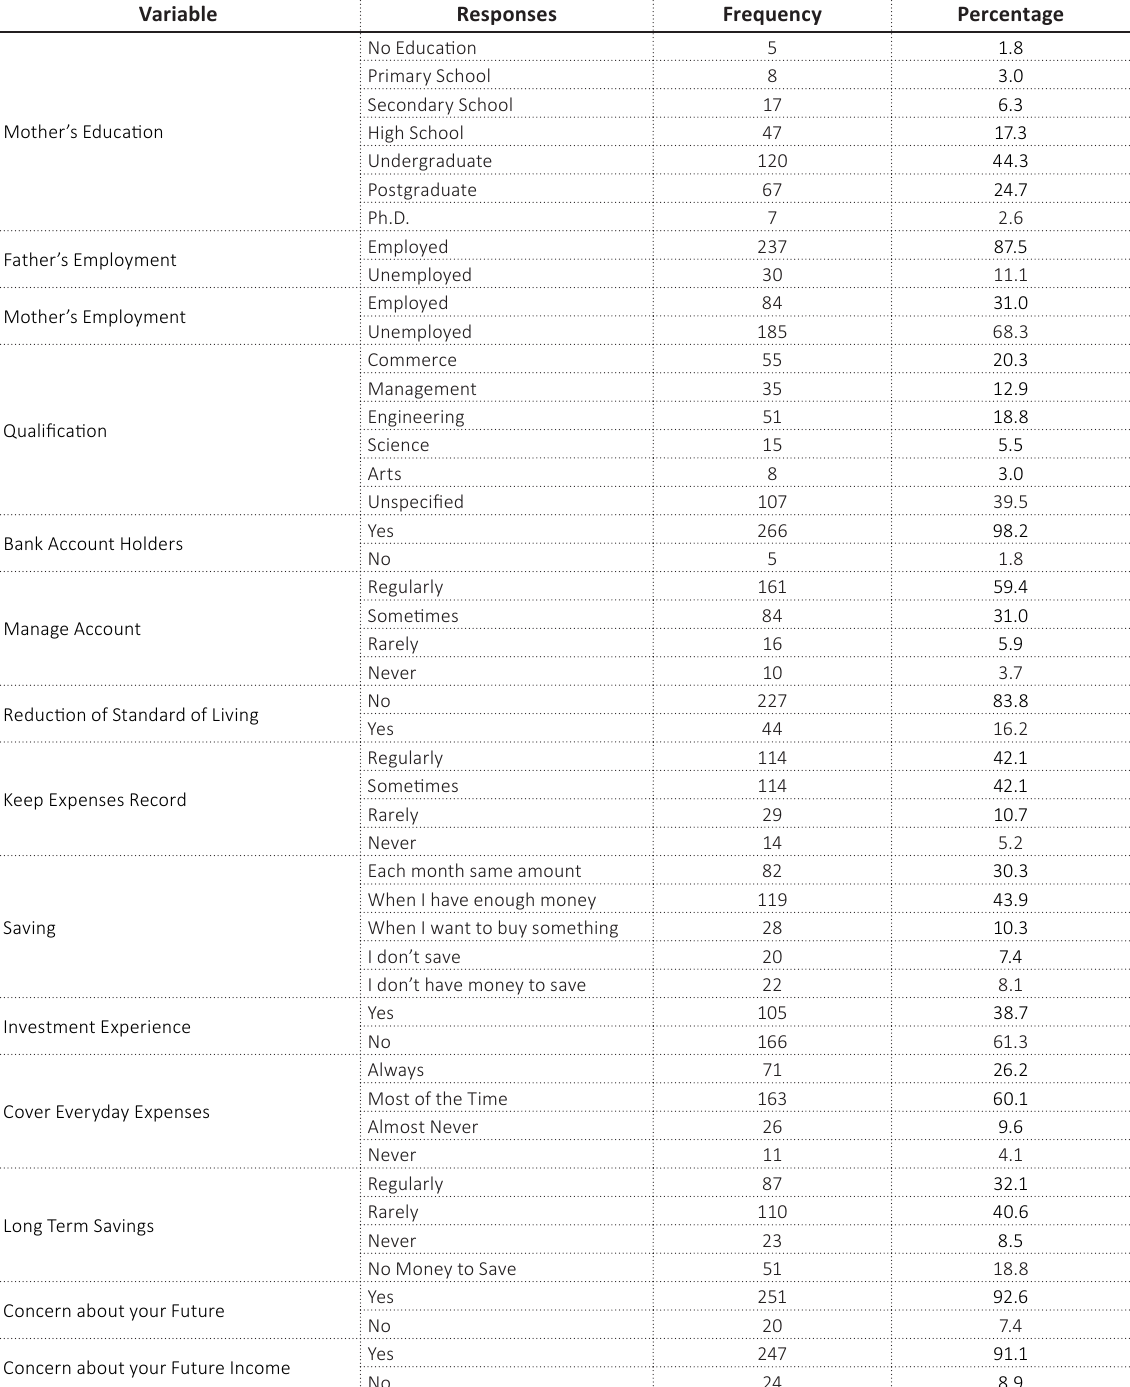
Table 1 (cont.). Demographic and financial profile of 271